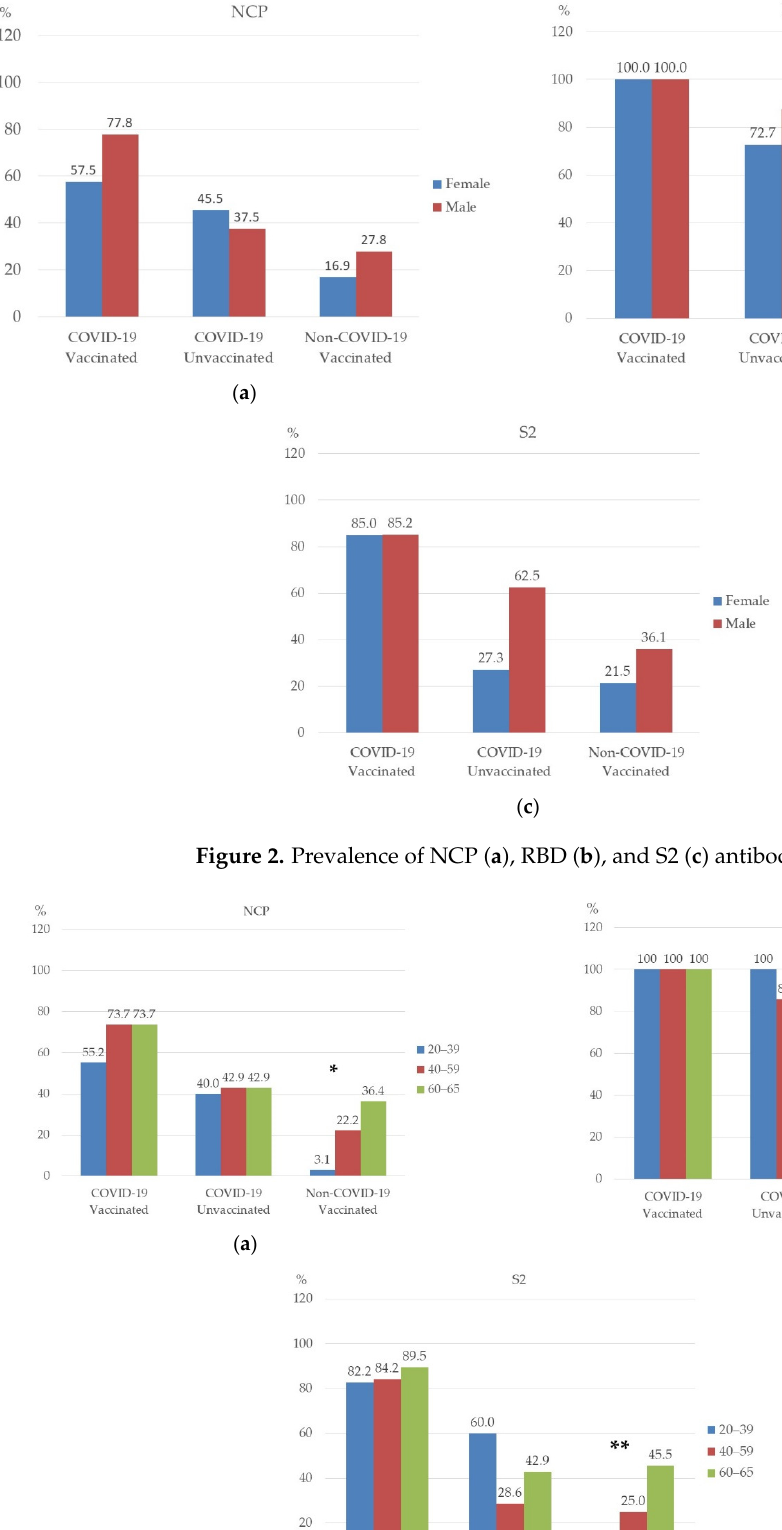
Table 3. The level of NCP, RBD, and S2 antibodies (U/mL) in the studied groups 1 . Participants’ Group